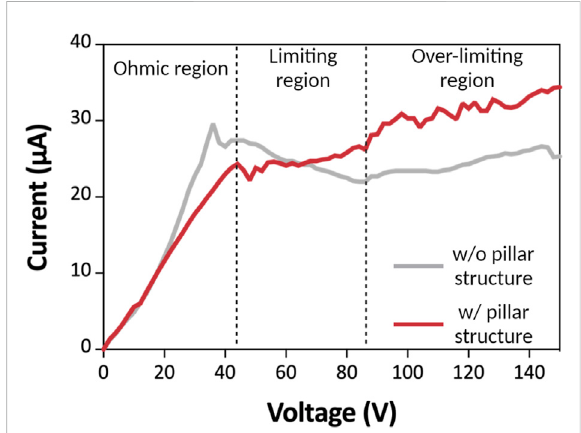
FIGURE 2 I-t curve of 3DP 2 with an applied voltage of 100 V within 170 s. I-t curve of the 3DP 2 without (gray line) and with (red line) a pillar-structured channel. The current decreases according to the propagation of the depletion zone.